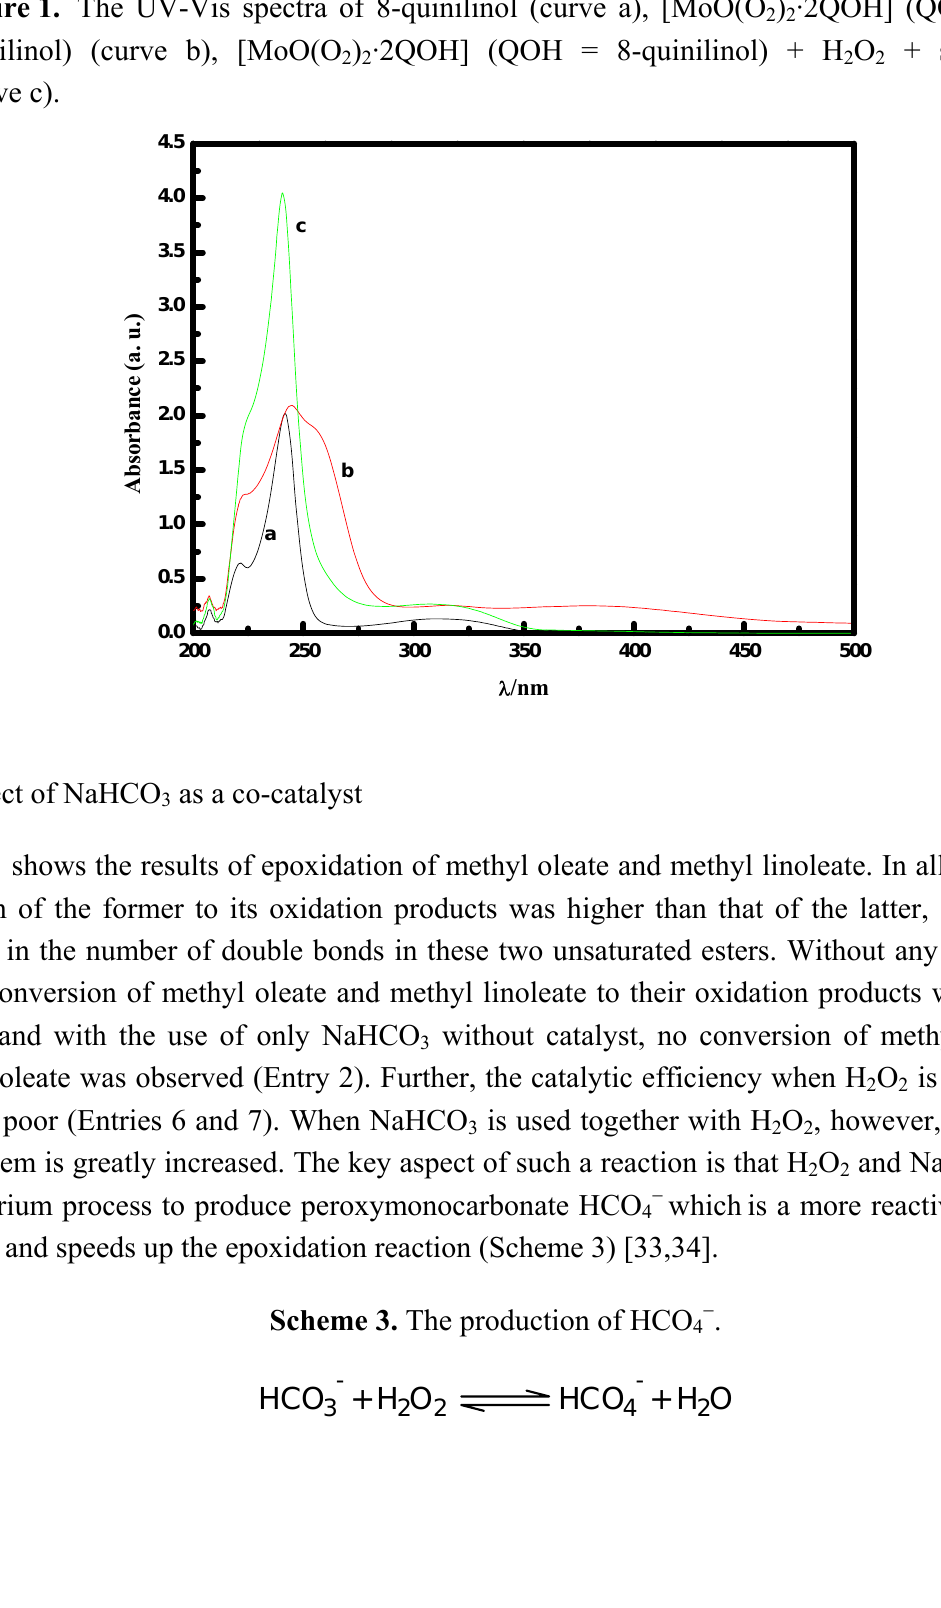
) ·2QOH] (QOH = 8-quinilinol) + H 2 2